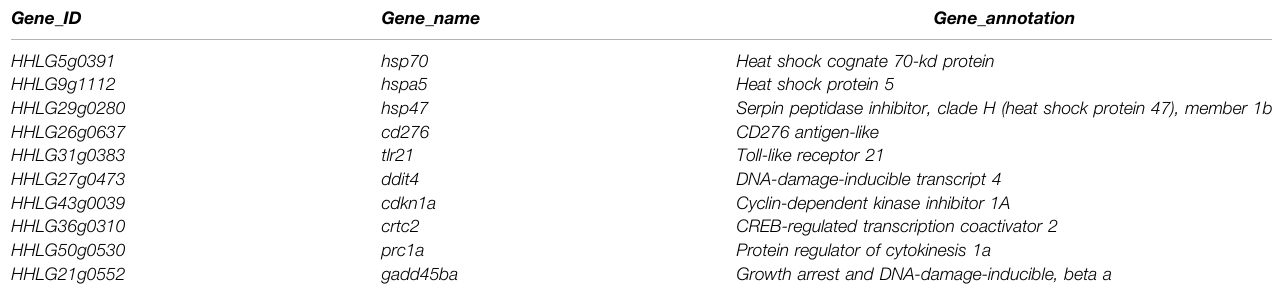
TABLE 1 | The core hypoxia-stressed genes in common